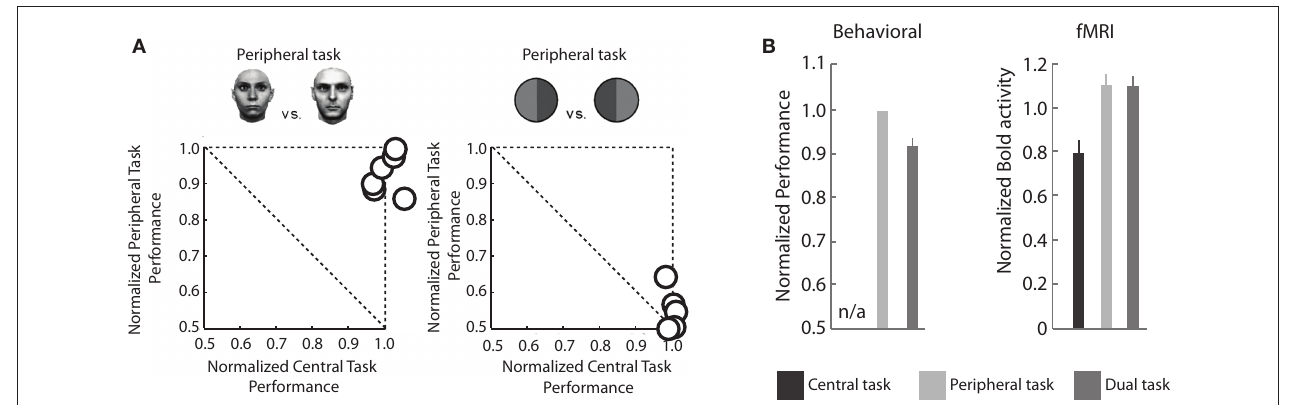
Figure 1 | Consciousness without attention: Behavioral performance and fMri measures in the dual-task paradigm. (A) Typical results in an experiment comparing single task performance (normalized and plotted along the x and y axes, such that they function as a reference for dual-task performance), and dual-task performance. The left panel shows the performance for gender discrimination and the central attention-demanding task when performed simultaneously. Each circle corresponds to the dual-task performance of one subject. Performance is near optimal for both tasks, even though the central letter task is highly demanding. The right panel shows data for a peripheral task involving discriminating a green-red